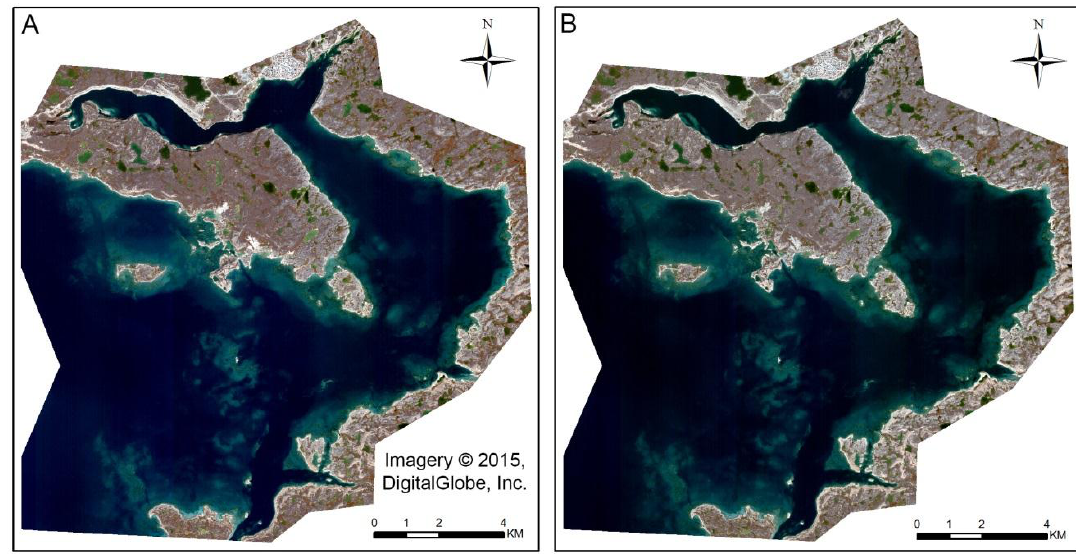
Figure 3. WordView-2 stereo-pair acquired on 20 September 2015: ( A ) forward image, ( B ) backward image. Imagery © 2015, DigitalGlobe, Inc. Table 3. Image and stereo-pair geometry.